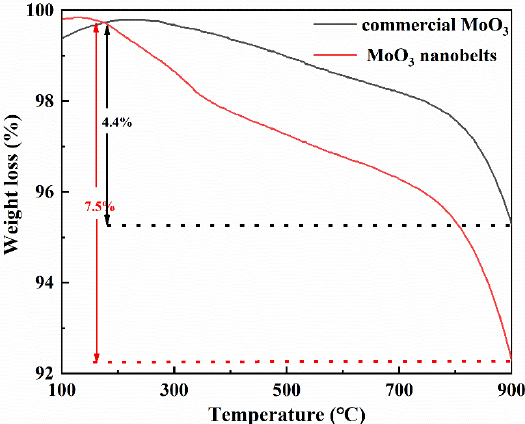
Figure 13. Thermogravimetric analysis of commercial MoO 3 and MoO 3 nanobelts.